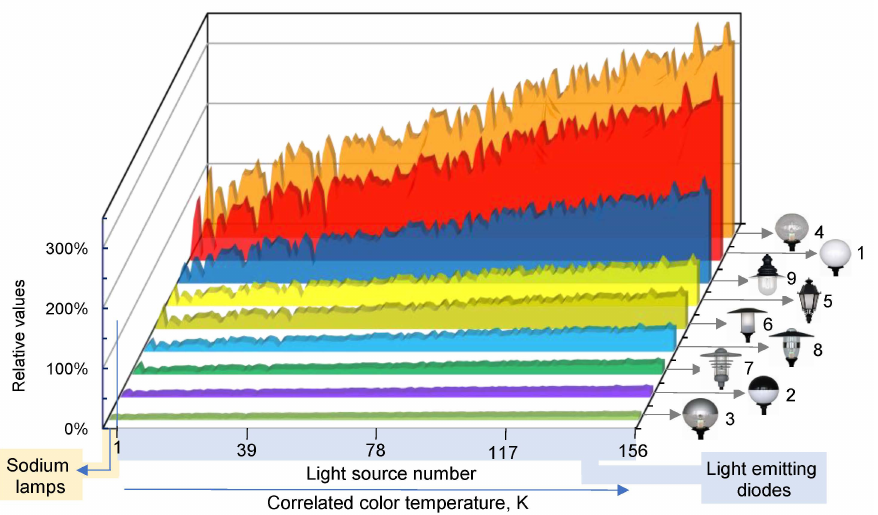
Figure 13. Relative influence on the effect of light pollution by the luminaires with different luminous